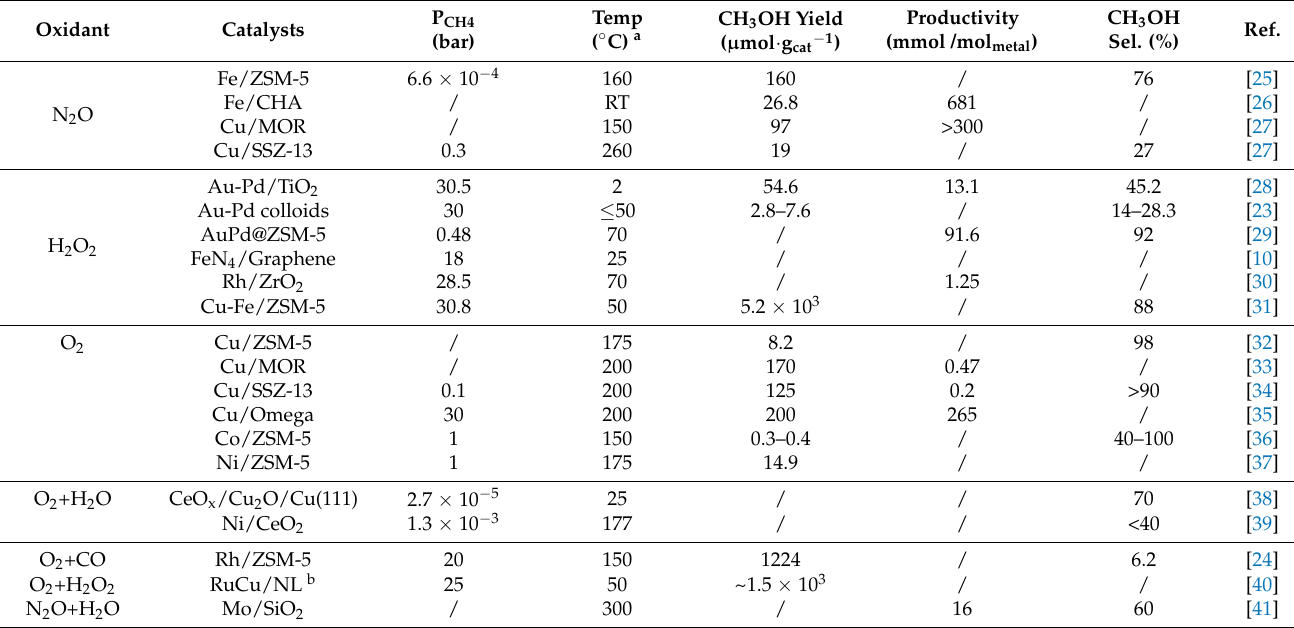
Table 1. Selected experimental results of direct oxidation of methane to methanol (DOMTM) based on different oxidants. Oxidant